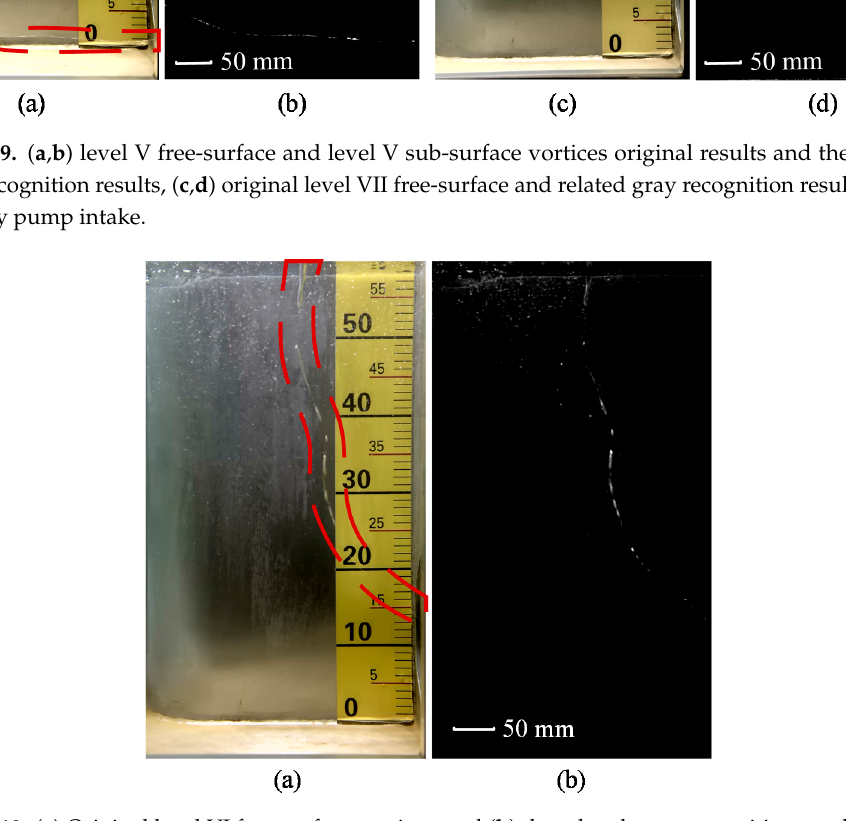
Figure 10. ( a ) Original level VI free-surface vortices, and ( b ) the related gray recognition results in the primary pump intake.